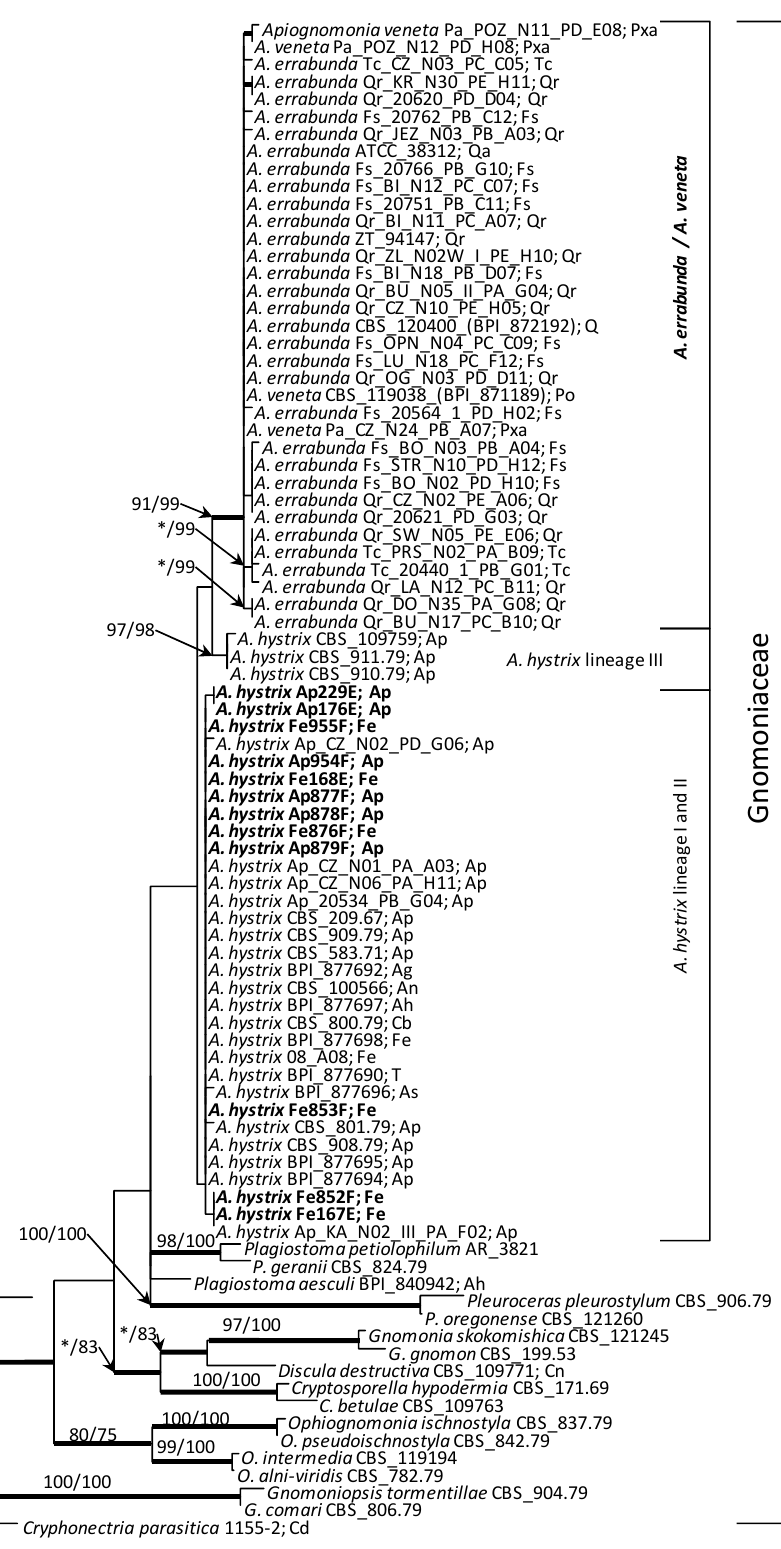
Figure 5. Phylogram obtained in maximum likelihood (ML) analysis of the ITS dataset of the Apiognomonia spp. and selected species from Gnomoniaceae. Sequences obtained in this study are marked in bold type. The bootstrap values ≥ 75% for ML and maximum parsimony (MP) analyses are presented at the nodes using ML/MP pattern. Bold branches indicate posterior probability values ≥ 0.95 obtained in Bayesian Inference (BI) analysis. * Bootstrap values < 75%. The tree is drawn to scale (see bar) with branch length measured in the number of substitutions per site. Cryphonectria